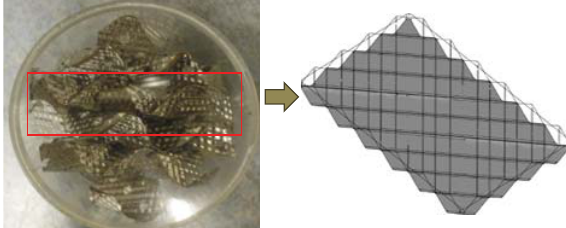
Figure 16: Comparison of domains used in simulation from real packing geometry.